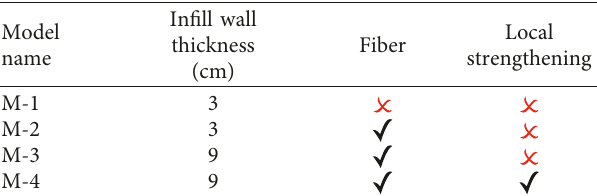
Figure 7: Comparison of the force-displacement curves of the benchmark model and the corresponding experimental specimen. Table 3: Characteristics of the